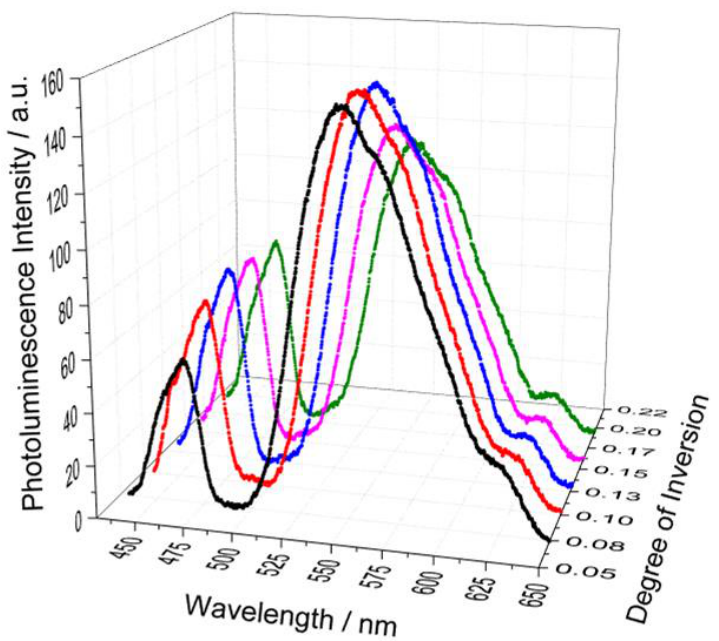
Figure 4. Time-averaged room-temperature photoluminescence of the ZFO pellets as a function of the degree of inversion. An excitation wavelength of 355 nm with an emission slit width of 10 nm was used for the measurement.